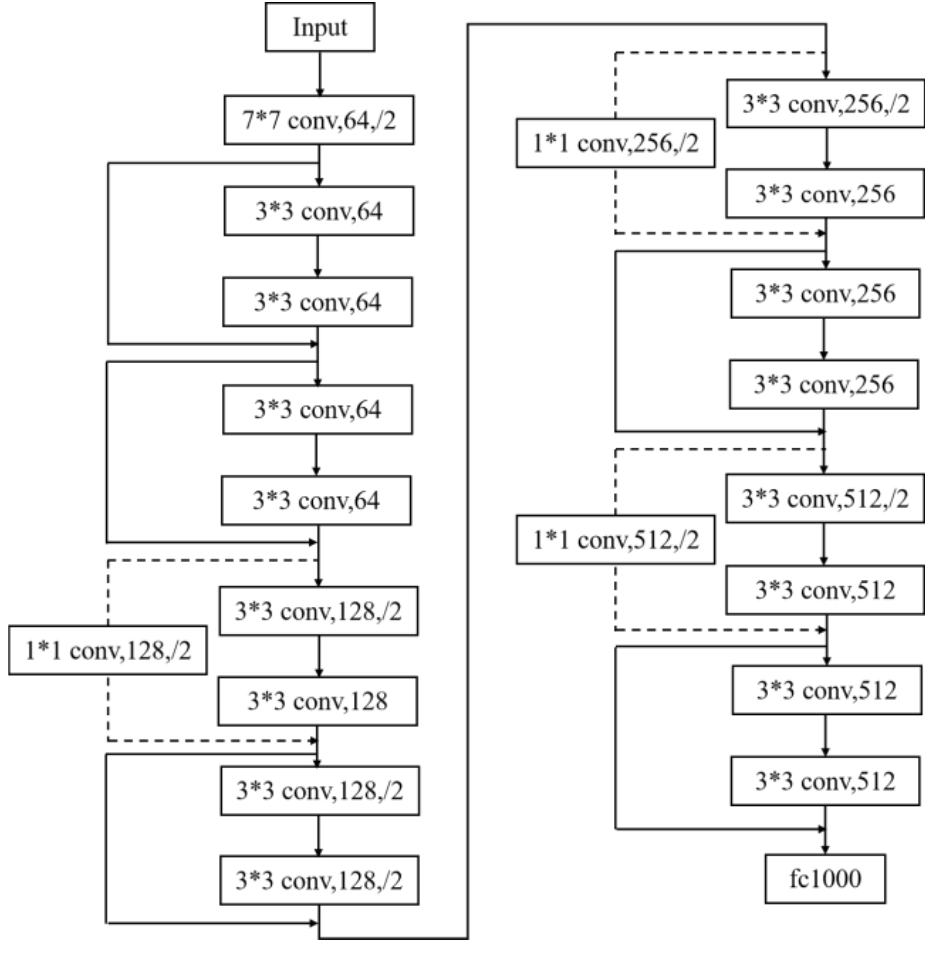
Figure 7. ResNet18 model framework.